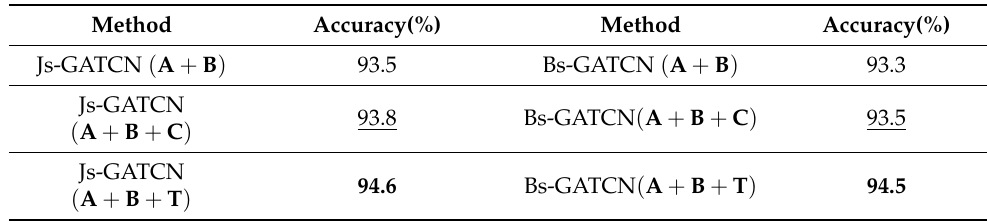
Table 2. Effectiveness validation of the matrix T